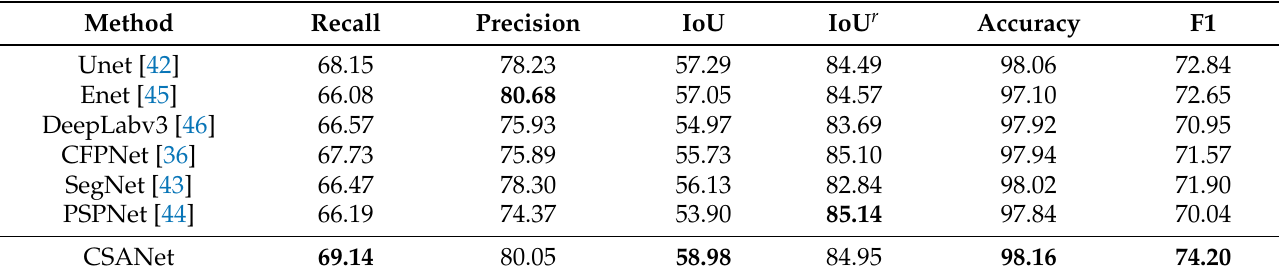
Table 1. Qualitative comparison of the proposed method (CSANet) with other methods on the Massachusetts Roads